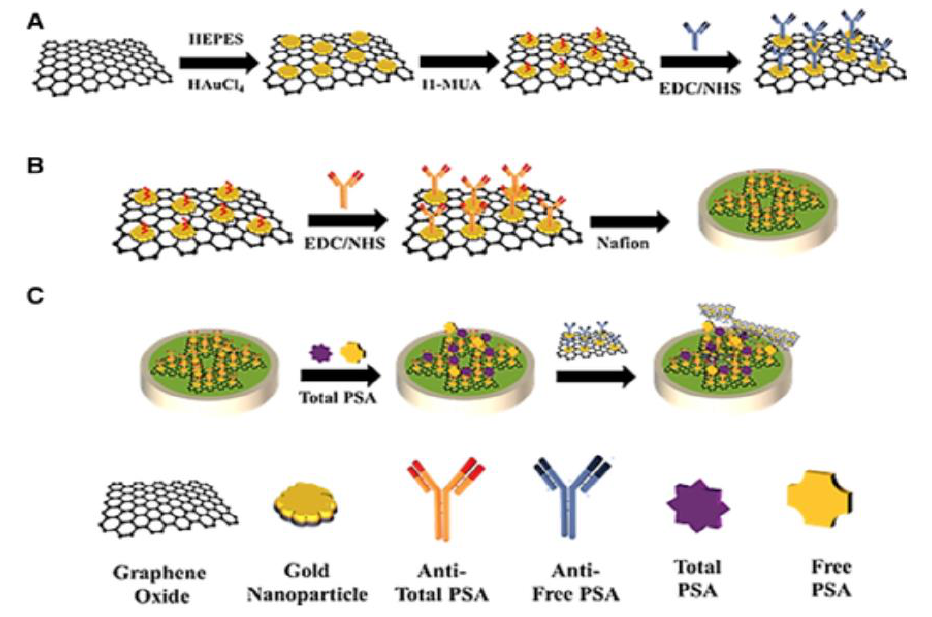
Figure 7: (A) Synthesis of graphene oxide, GNPs and anti-total PSA antibody; (B) anti-total PSA antibody is attached to the surface of the electrode of the biosensor to capture antigens; (C) Following a sandwich-like system, the resulting product from (B) is incubated with graphene oxide and GNPs [16].